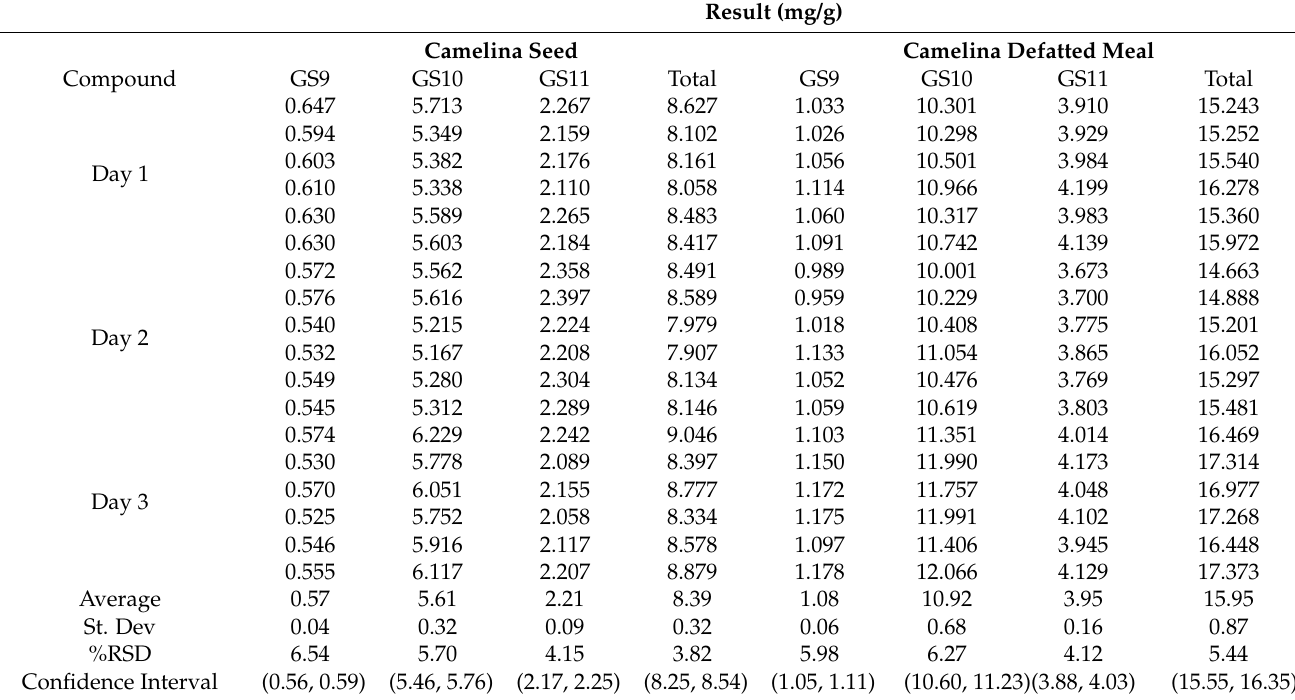
Table 3. Precision data of Camelina Seed and Camelina Defatted Meal. Camelina oil data are not shown because their GS9-11 levels were non-detectable. Result (mg/g)